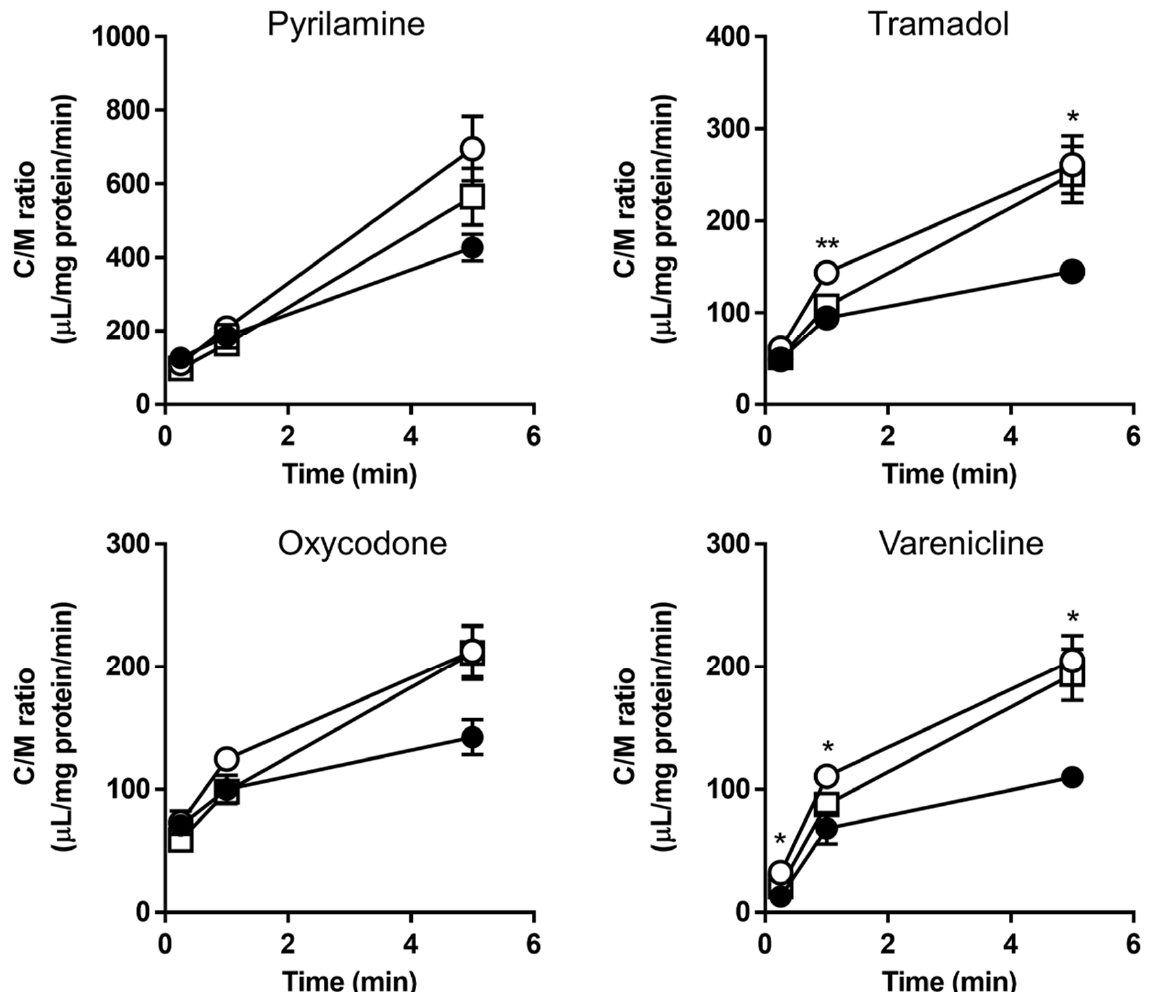
Figure 4. Uptake of H + /OC antiporter substrates by HEK293 cells stably double-transfected with LHFPL6 and TM7SF3. The time-courses of uptake were assessed at 37 °C in mock (closed circle) and HEK293 cells stably transfected with TM7SF3 (open circle) or both LHFPL6 and TM7SF3 (open square). Each point represents the mean ± standard error ( n = 3). * p < 0.05 and ** p < 0.01 indicate significant differences in the uptakes by mock and TM7SF3-transfected